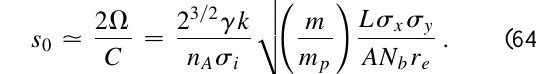
can intersect in a couple of points (open circles and solid lines in Figs. 8 and 9). Near these intersection points the value of D (cid:116)